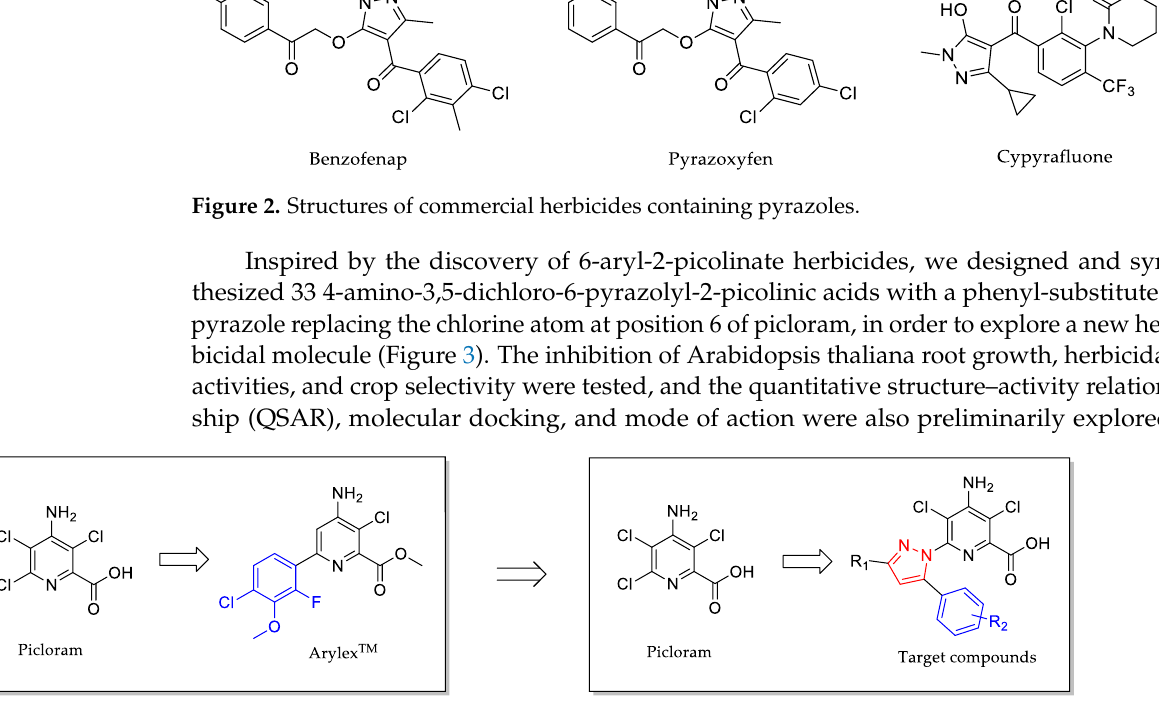
Figure 3. Design strategy of target compounds.